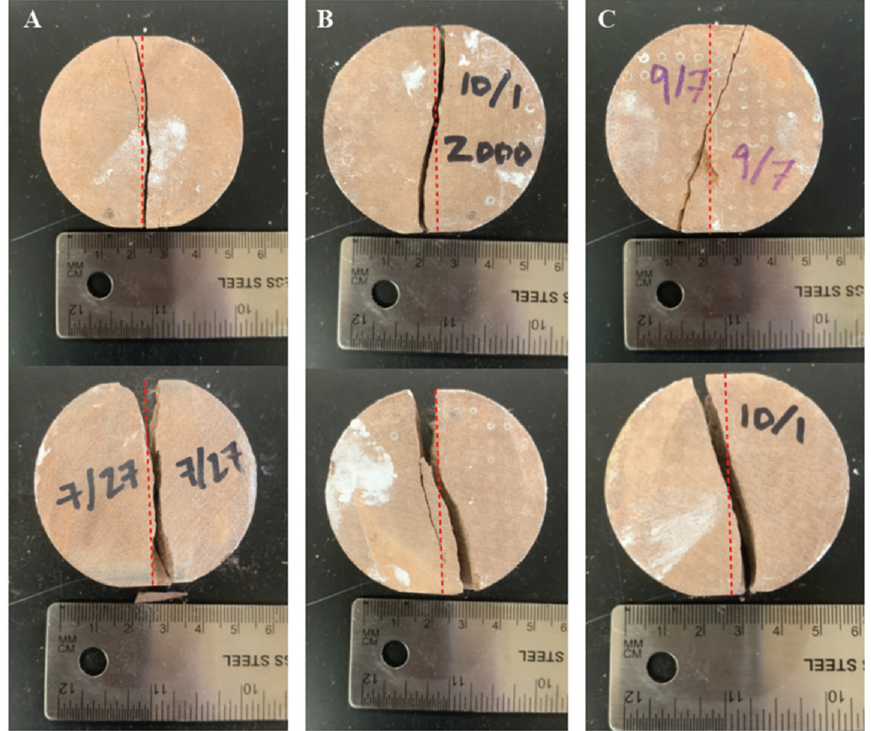
Figure 9. The fracture pattern differences due to confining pressure. Column ( A ) failed under a confining pressure of 2.76 MPa (sample A-8 and A-7), Column ( B ) at 13.79 MPa (sample A-19 and A-17), and Column ( C ) failed at 27.58 MPa (sample A-23 and